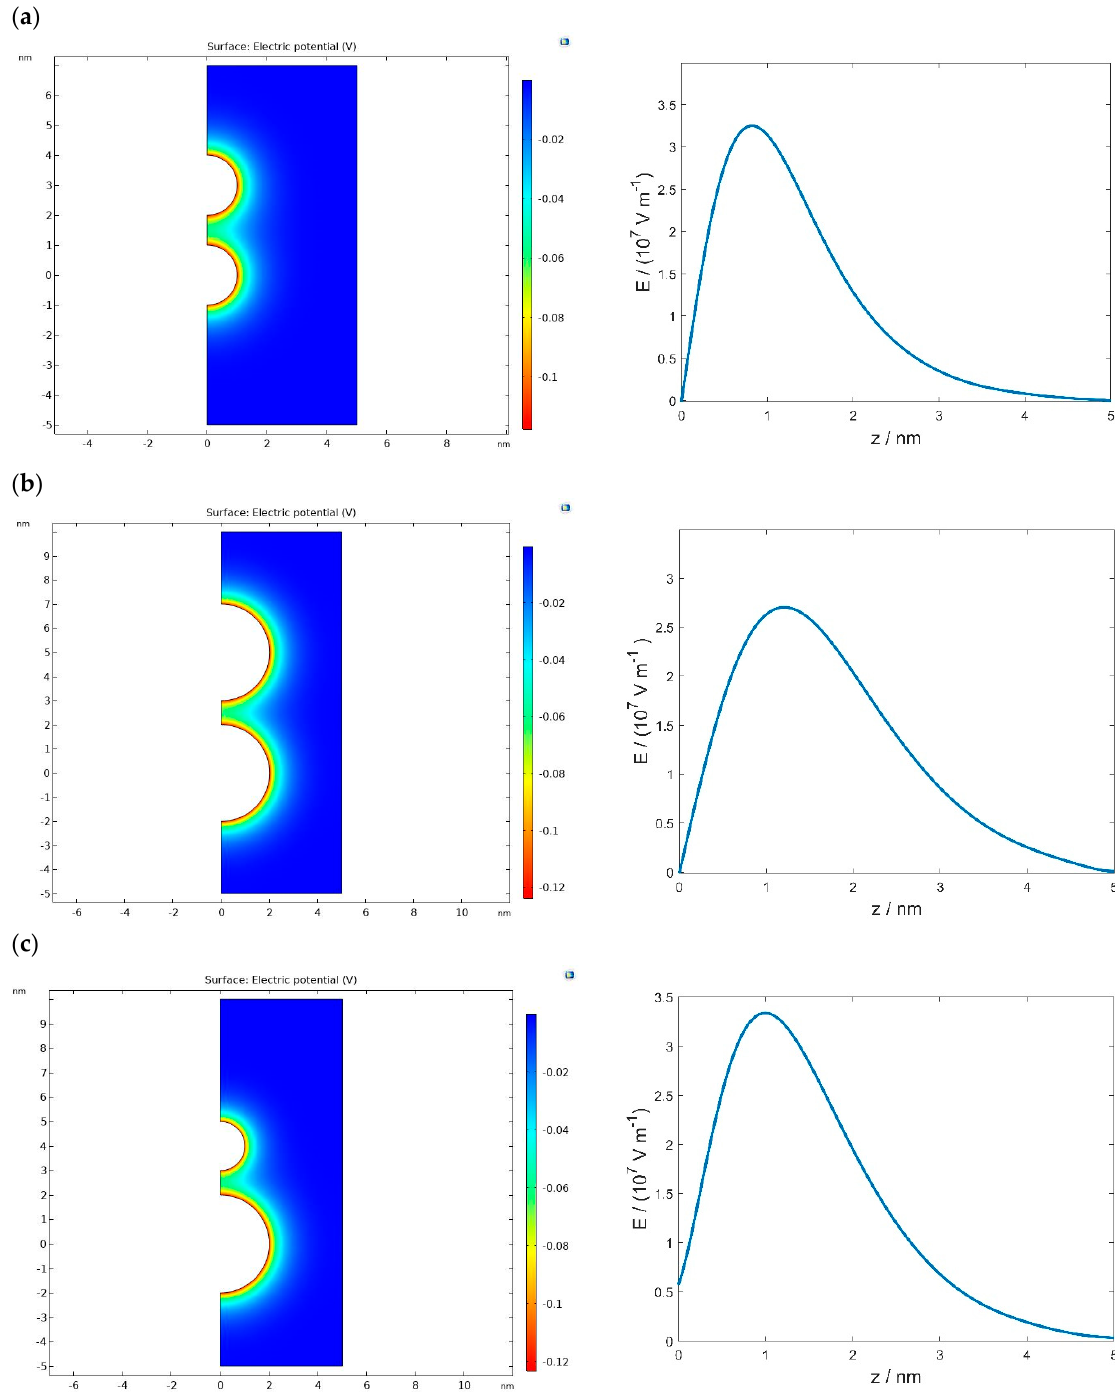
Figure 3. Distribution of the electric potential and the magnitude of the electric field strength along the line passing through the midpoint between the surface of both spheres perpendicular to the line connecting the centres of the sphere (see Figure 4). The calculation were performed by solving the modified LPB eqution (Equations (1)–(3)) for two spheres with equal surface charge densities σ = − 0.25 As/m 2 . The radii of the spheres are R p = R = 1 nm ( a ), R p = R = 2 nm ( b ), and R p = 2 nm and R = 1 nm ( c ) (see also Figure 4). The values of other parameters are H = 1 nm (see Figure 4), p 0 = 3.1 Debye, n 0 / N A = 0.15 mol/L, n w / N A = 55 mol/L, and T = 298